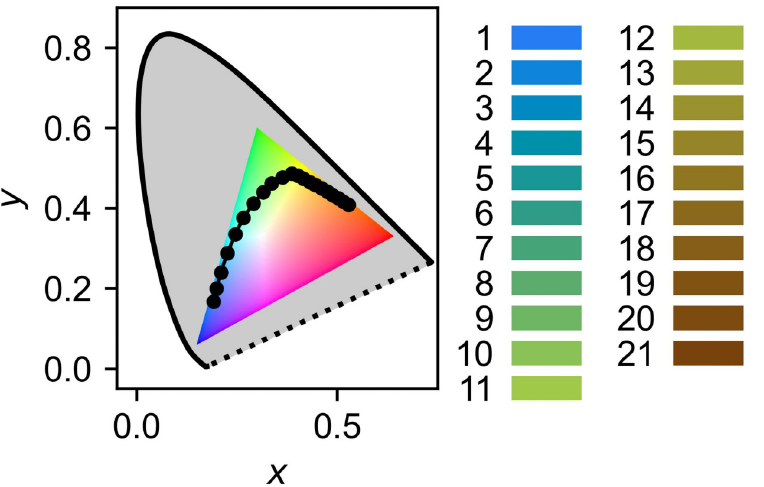
Fig 1. The Forel-Ule scale. The individual FU colours are shown on the right, a comparison to the human gamut on the left. The gamut is plotted in ( x , y ) chromaticity, normalized from CIE XYZ and shown with a constant brightness, and converted to sRGB. The FU scale increases from 1 (bottom left) to 21 (far right). The shaded area represents the full gamut of regular colour vision, while the coloured triangle represents the sRGB colour space, which most computer monitors are limited to. The perceived colours may vary depending on monitor or printer settings and the reader’s own colour vision.